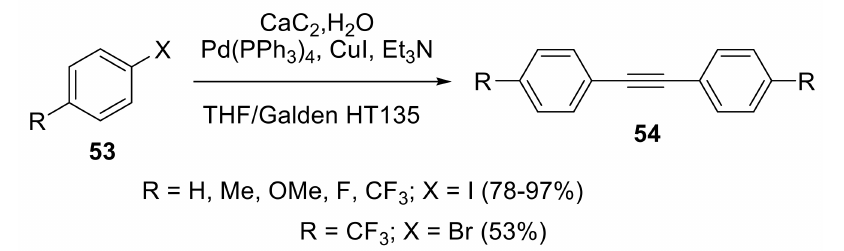
Scheme 28. Cross-coupling with CaC 2 -derived